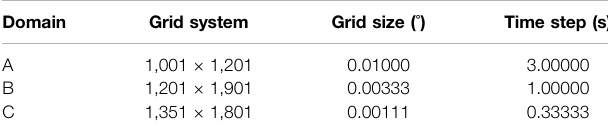
TABLE 2 | Description of the East Sea high-resolution grid system used in the present